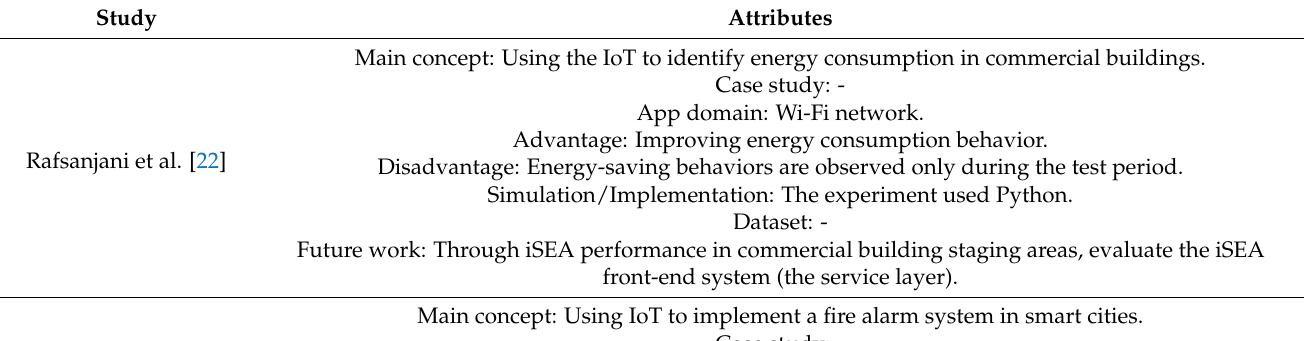
Table 12. Categorizing the state-of-the-art in smart building